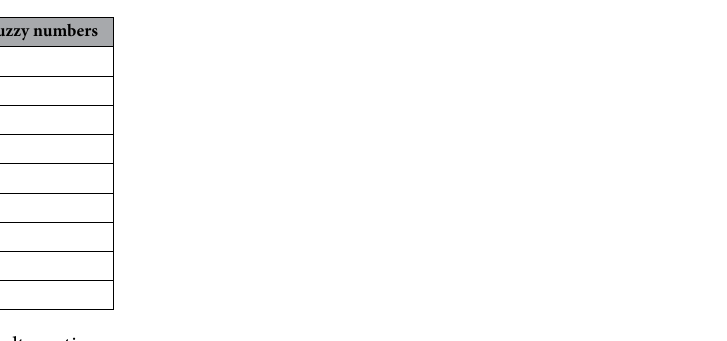
Table 2. Evaluation scale for alternatives.